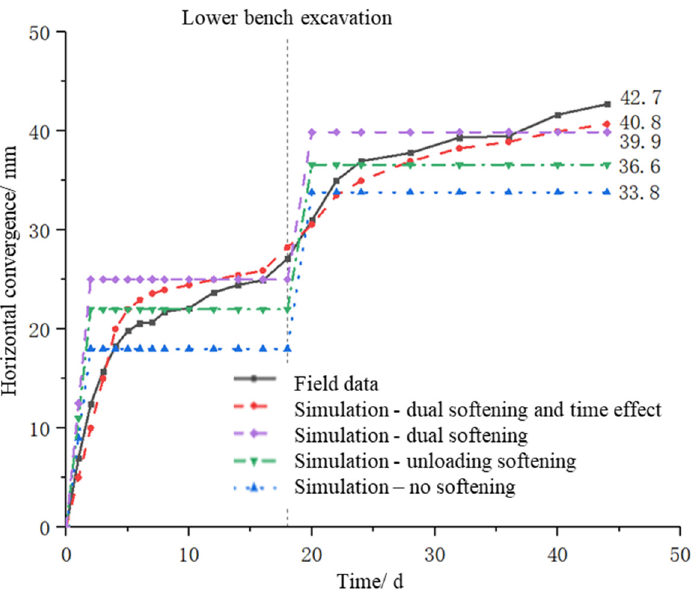
Figure 21. Curves of field monitoring and simulations of horizontal convergence at section K14 + 885.